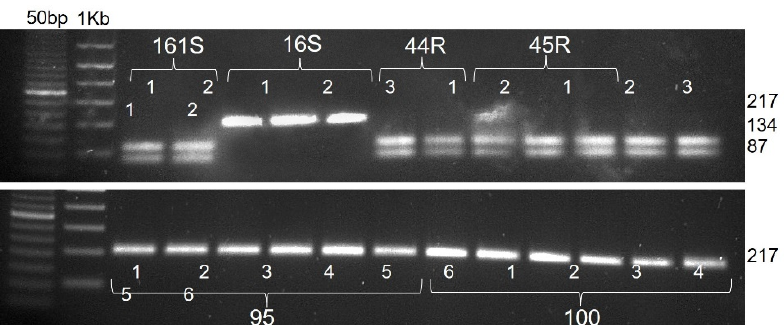
Figure 1. Cladogram obtained from UPMGA estimation of nine Echinochloa rbcL sequences from GenBank database (identified by GenBank ID, e.g. KT365291.1) and 14 sequences from seven previously identified accessions (e.g. 41A and 41B are two plants derived from seeds of the same mother plant) harvested in Italian rice fields.